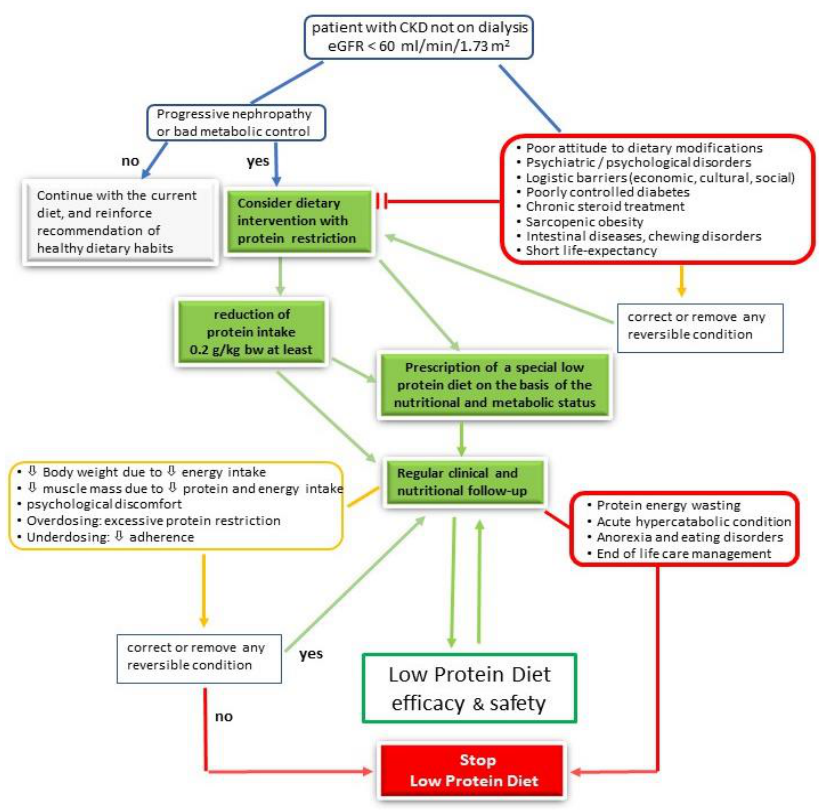
Figure 2. Low protein diet as medication: a flow chart for prescription.